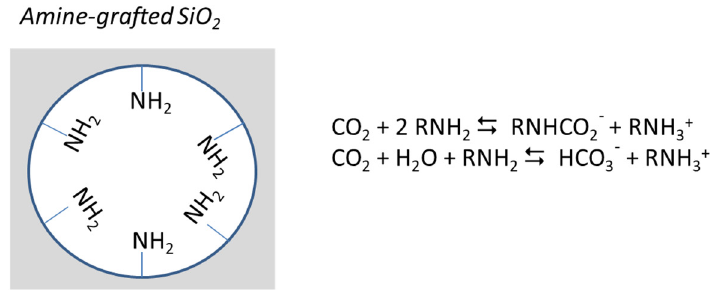
Figure 1. Mechanism of CO 2 capture over amine-modified silica.